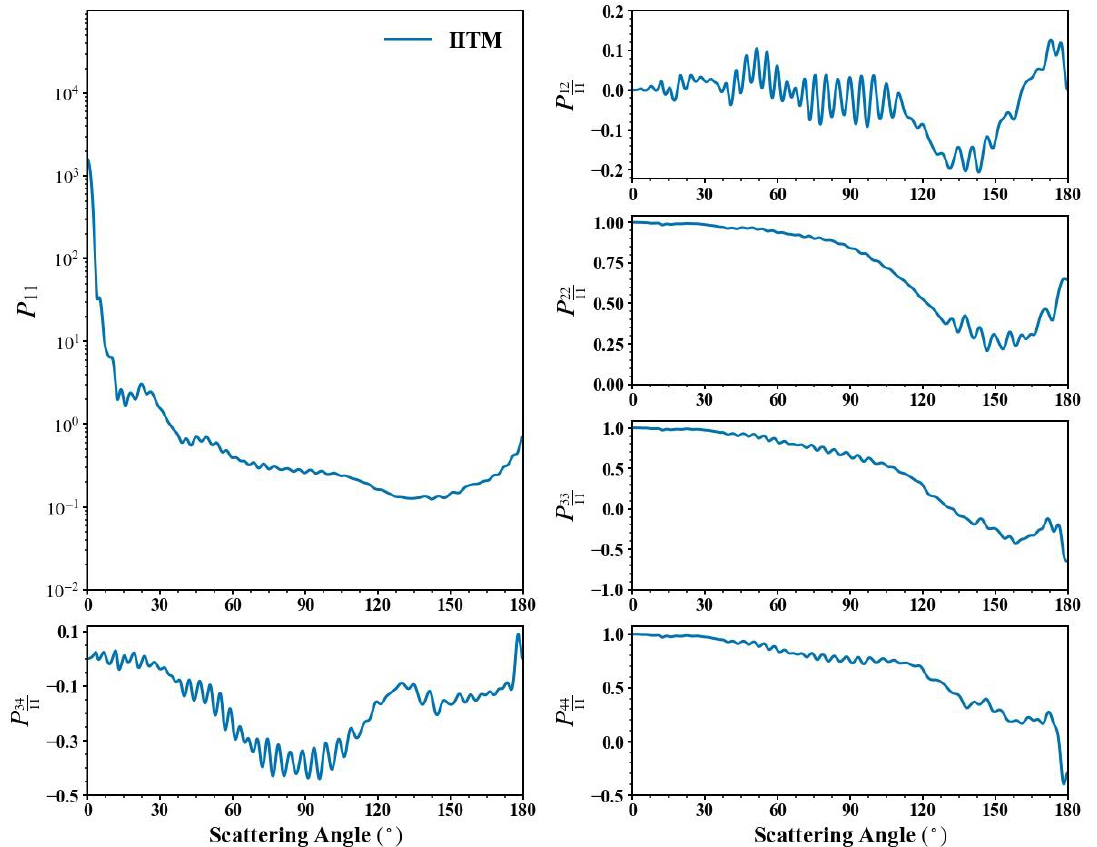
Figure 6. Six elements of IITM phase matrix at a wavelength of 0.4 μm for a size parameter of 50.